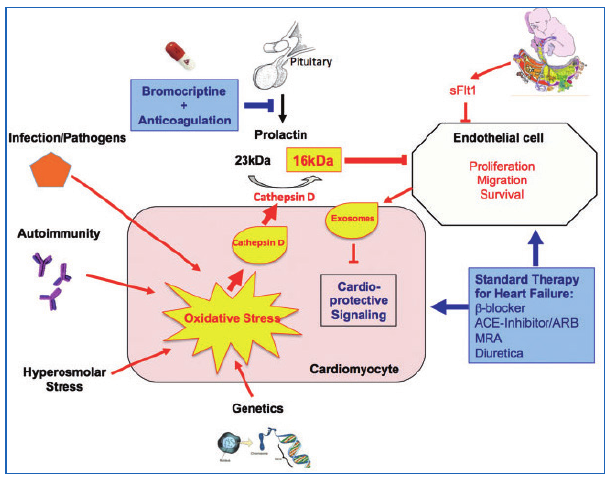
Figure 3. Disease specific therapy with bromocriptine